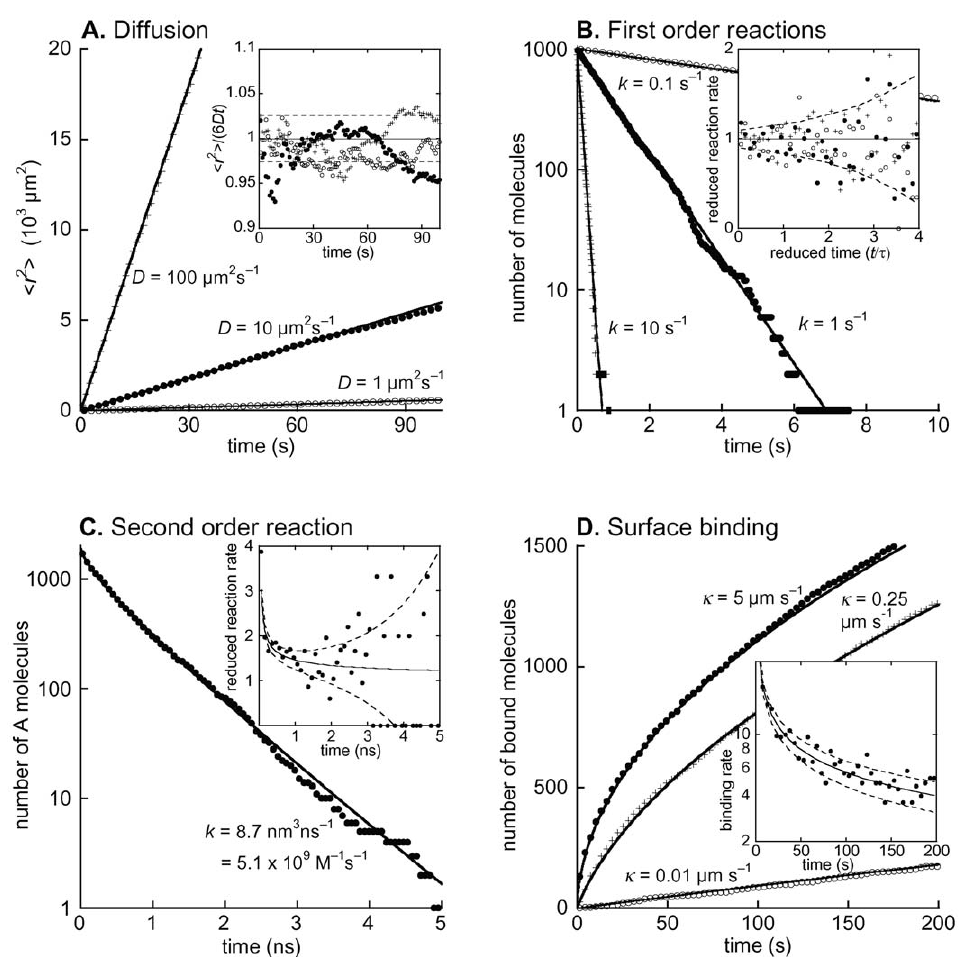
Figure 3. Tests of Smoldyn accuracy. Each panel presents simulation results with points and theoretical results for the same parameters with solid lines. Where present, different shape points represent simulation data for different rates. Inset panels present fluctuations of the same simulation data shown in the main panels, with parameters that are reduced so as to highlight the fluctuations and provide meaningful comparisons between data sets. Here, solid lines represent theoretical expectation values and dashed lines are drawn one standard deviation, analytically calculated from theory, above and below the expectation values. Configuration files and analytic calculations are included with Text S2. (A) Mean square displacements of three populations of freely diffusing molecules that have the listed diffusion coefficients. (B) First order decay reactions (A R Ø) of three populations of molecules that have the listed reaction rate constants. The reduced reaction rate is the reaction rate per molecule per unit of reduced time. (C) Bimolecular association and decay reaction between A and B molecules (A + B R Ø), using the same parameters that are presented in Figure 7 of Andrews and Bray [21]. The reduced reaction rate is the reaction rate per A molecule. (D) Adsorption of molecules that are uniformly distributed initially to planar surfaces with the listed adsorption coefficients. The inset panel shows fluctuations in the k =5 m m s 2 1 simulation